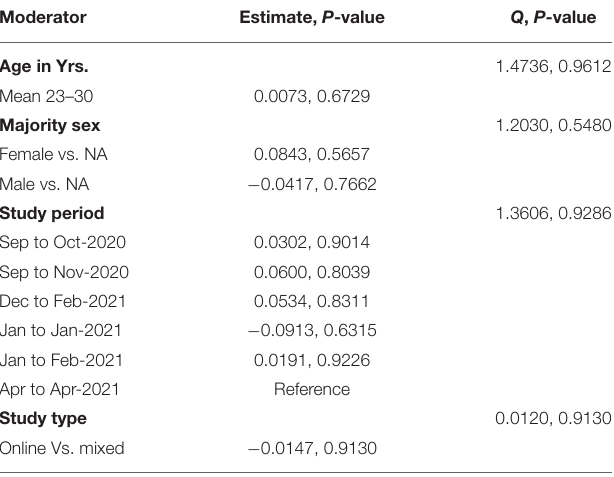
TABLE 1 | Meta-regression analysis: test for moderators.